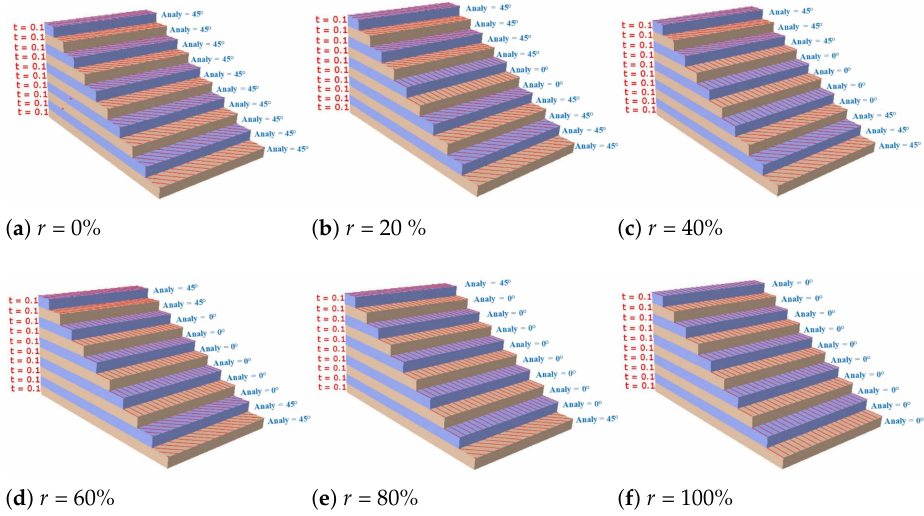
Figure 15. Six different 0 ◦ -ply ratios in the layup combination of 0 ◦ and 45 ◦ plies. Figure 16a shows that the influences of the 0 ◦ -ply ratio on A 11 and D 11 were much greater than those on the other stiffness components because the stiffness along the fiber direction (0 ◦ direction) was stronger. Figure 16b shows that the first natural frequency increased with increasing 0 ◦ -ply ratio and reached a maximum value when the 0 ◦ ply ratio was 100%. The third to fourth natural frequencies increased first and then decreased and reached the maximum value when the 0 ◦ -ply ratio was between 0.2 and 0.6. With the increase in the 0 ◦ -ply ratio, the first to fourth buckling loads of the OSFP increased gradually and reached a maximum value when the 0 ◦ ply ratio was 100%. In engineering applications, the effective performance of the OSFP in the corresponding direction can be improved by adjusting the 0 ◦ -ply